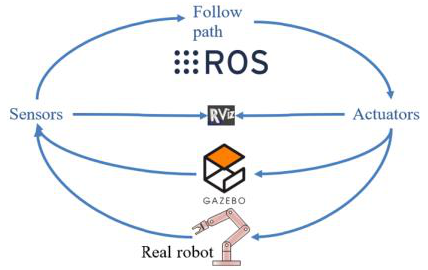
Figure 1. ROS is an open-source working environment, which includes connectivity with physical and real hardware (actuators and sensors). Gazebo (run 3D robot simulations) and RVIZ (allows a 3D visualization) modules complete a flexible framework that allows simulations and visualization in combination with ROS.